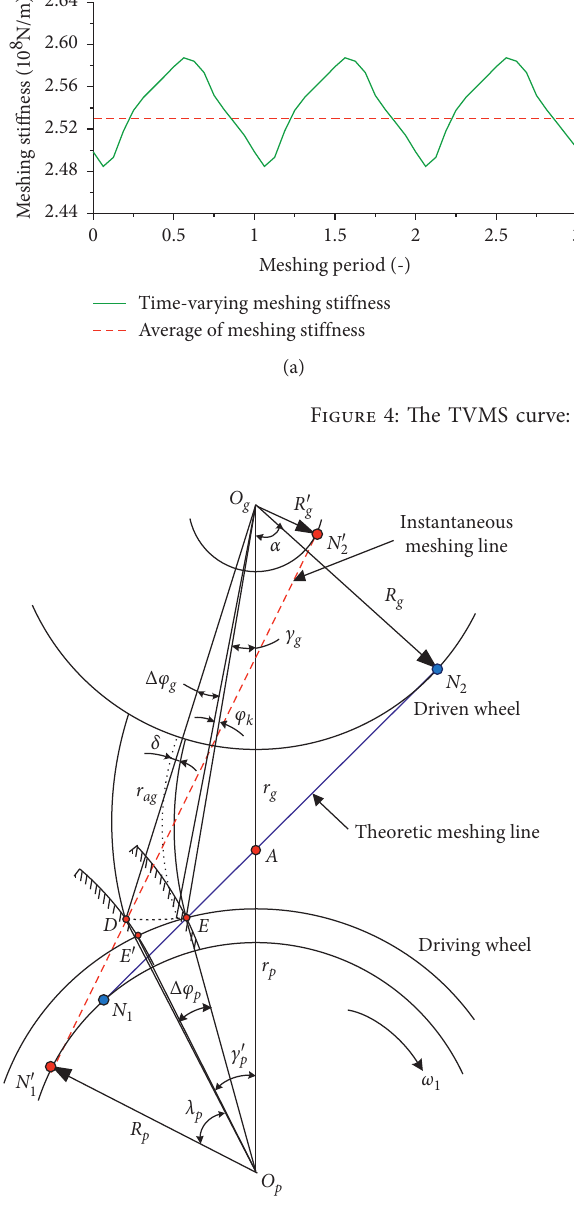
Figure 5: Schematic diagram of meshing-in impact.